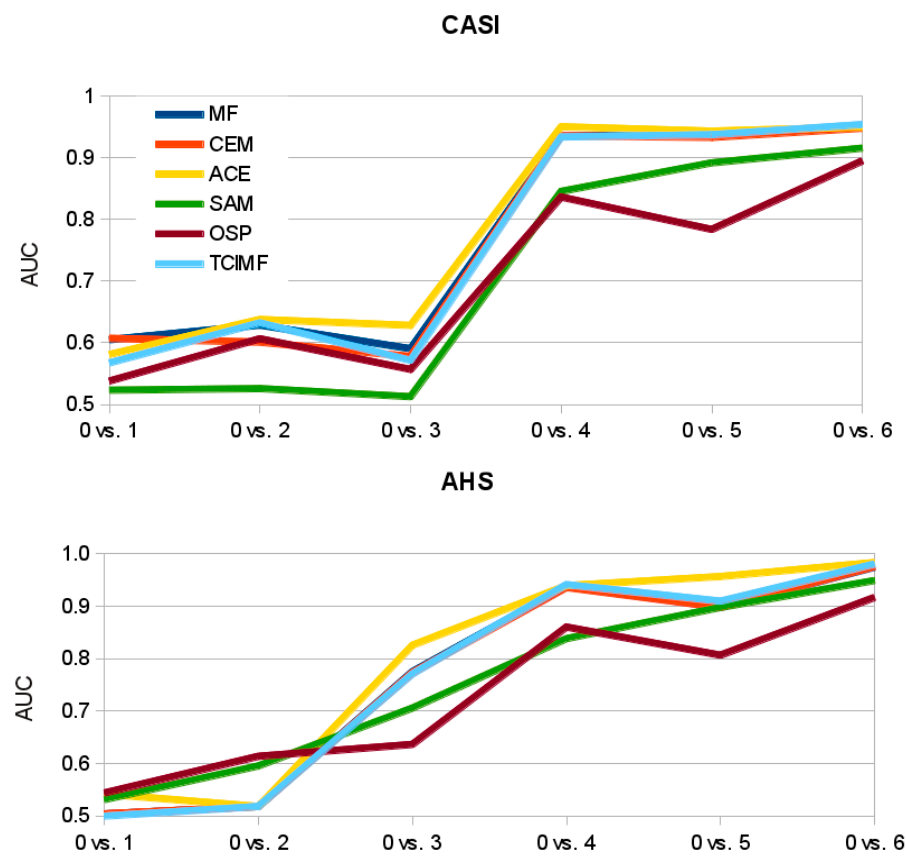
Figure 9. Comparative performance of algorithms to discriminate among S. densiflora ground-cover classes. Discrimination performance of each detection algorithm for CASI and AHS original images at the field validation site of “Codo de la Esparraguera”. SAM = Spectral Angle Mapper, MF = Matched Filter, CEM = Constrained Energy Minimization, ACE = Adaptive Coherence Estimator, OSP = Orthogonal Subspace Projection, TCIMF = Target-Constrained Interference-Minimized Filter. Sensors: CASI and AHS. The value in the graph indicates the AUC of a ROC plot to discriminate between the Class “0” of S. densiflora ground-cover and the remaining classes. Ground-cover classes: 0 = absence, 1 = presence < 5% cover, 2 = 5%–25%, 3 = 25%–50%, 4 = 50%–75%, 5 = 75%–99%, 6 = 100%. Sample sizes are 68, 7, 4, 7, 8, 20 and 15 respectively.